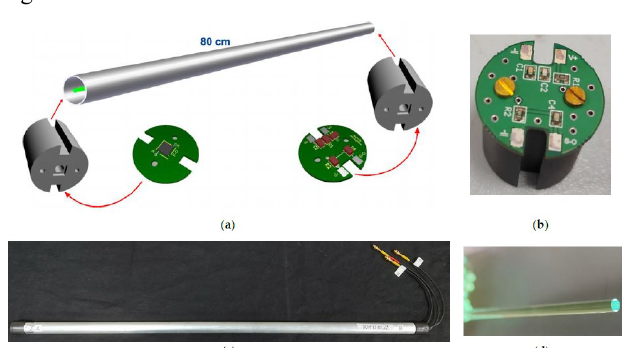
Fig. 7. (a) Sketch of the components of the SciFi detector assembly; (b) A fiber holder with the SiPM PCB in place; (c) A detector fully assembled; (d) A 3mm diameter